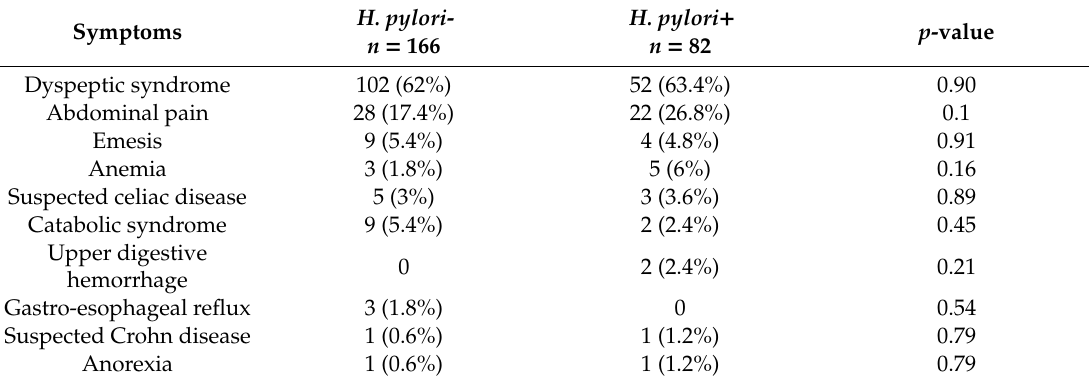
Table 3. Reasons for endoscopy in children with or without H. pylori infection.